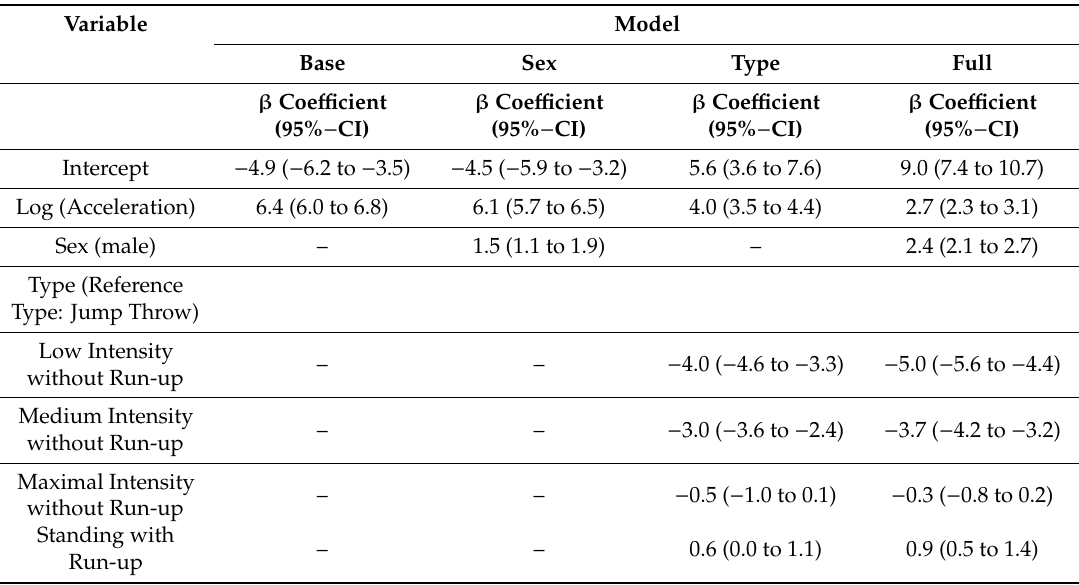
Table 3. Estimated coe ffi cient values for all models fitted to the entire dataset. CI = confidence interval.